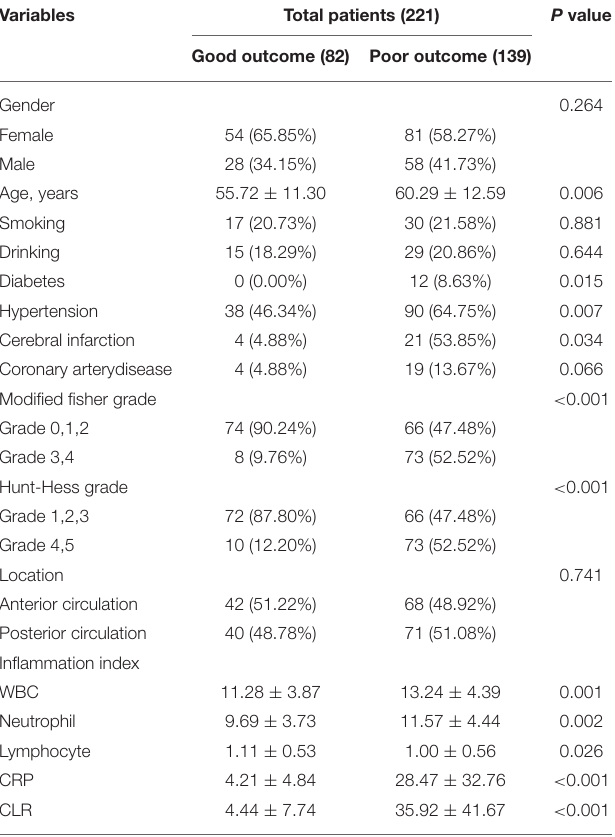
TABLE 1 | Univariate analysis table affecting the clinical prognosis of patients with Aneurysmal subarachnoid hemorrhage (aSAH).